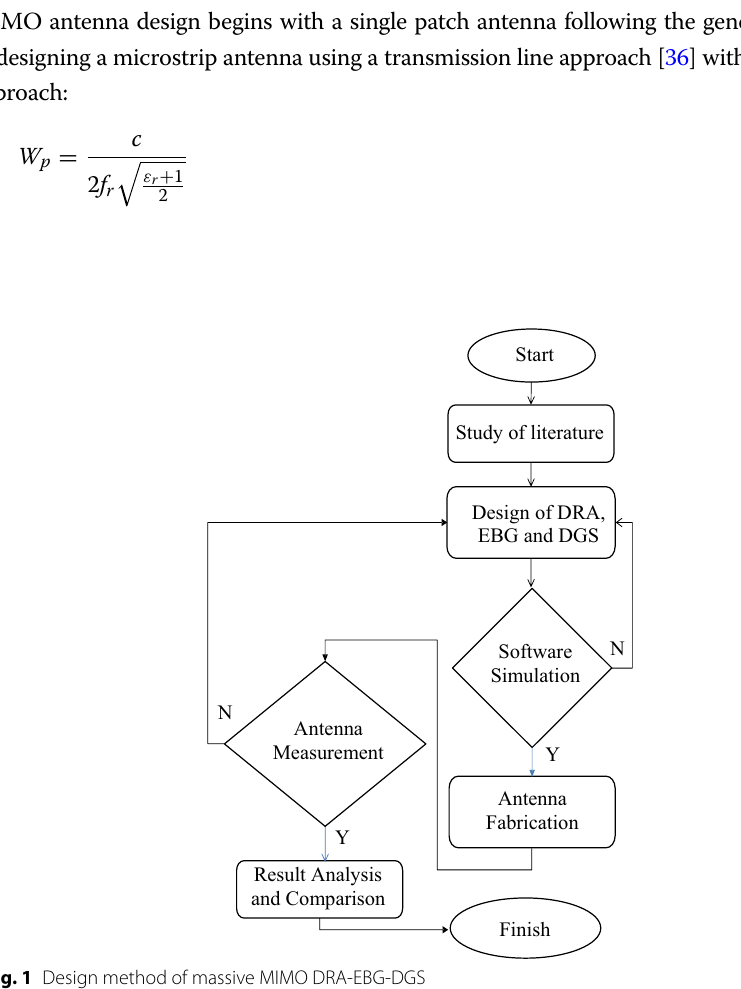
Fig. 1 Design method of massive MIMO